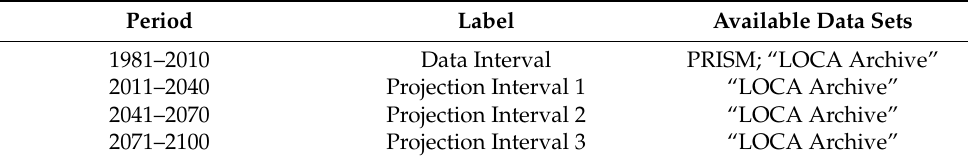
Table 2. Climate Normals